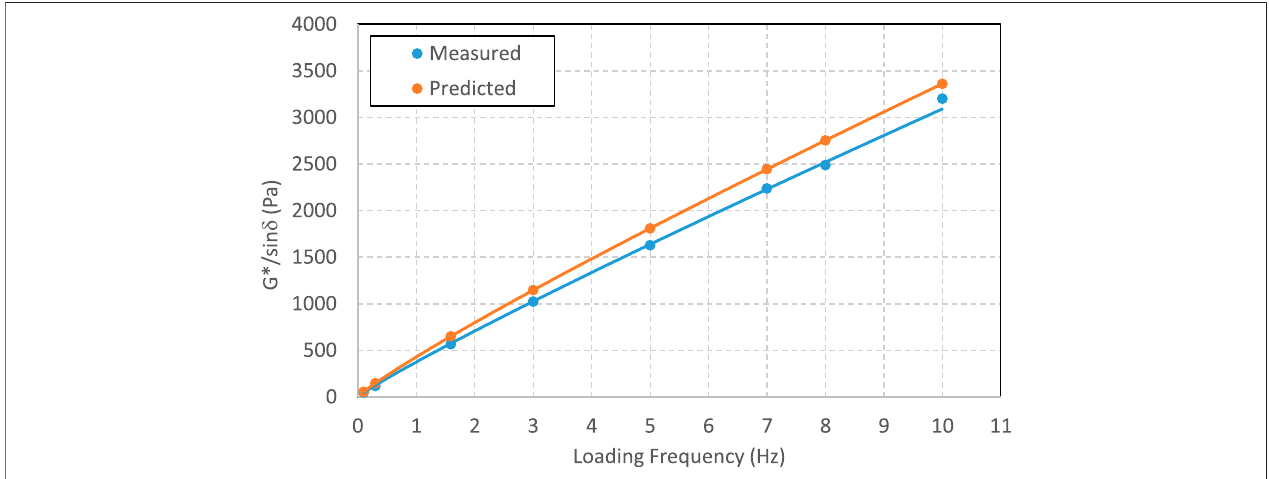
FIGURE 5 | Measured and predicted G*/sin δ value versus loading frequency for the unaged 20% cement-modi fi ed asphalt binder at 64 ° C.